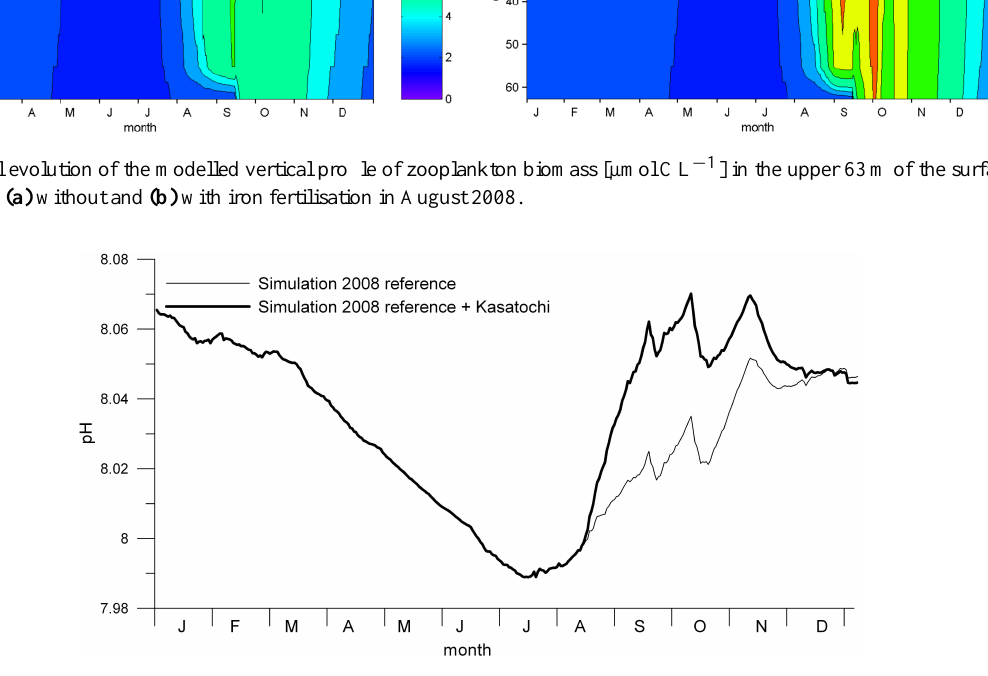
Fig. 12. Simulated pH in the upper 10m of the ocean without (thin line) and with Fe (thick line) deposition in August 2008 at